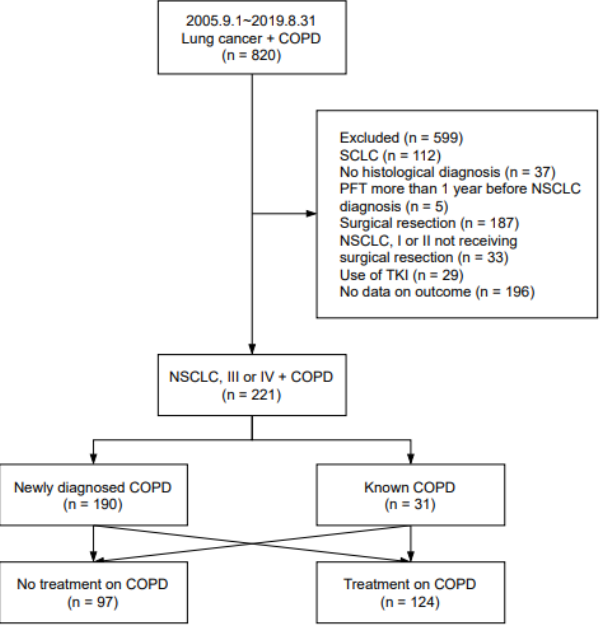
Figure 1. Study design. COPD, chronic obstructive pulmonary disease; SCLC, small cell lung cancer; PFT, pulmonary function test; NSCLC, non-small cell lung cancer; TKI, tyrosine kinase inhibitor.